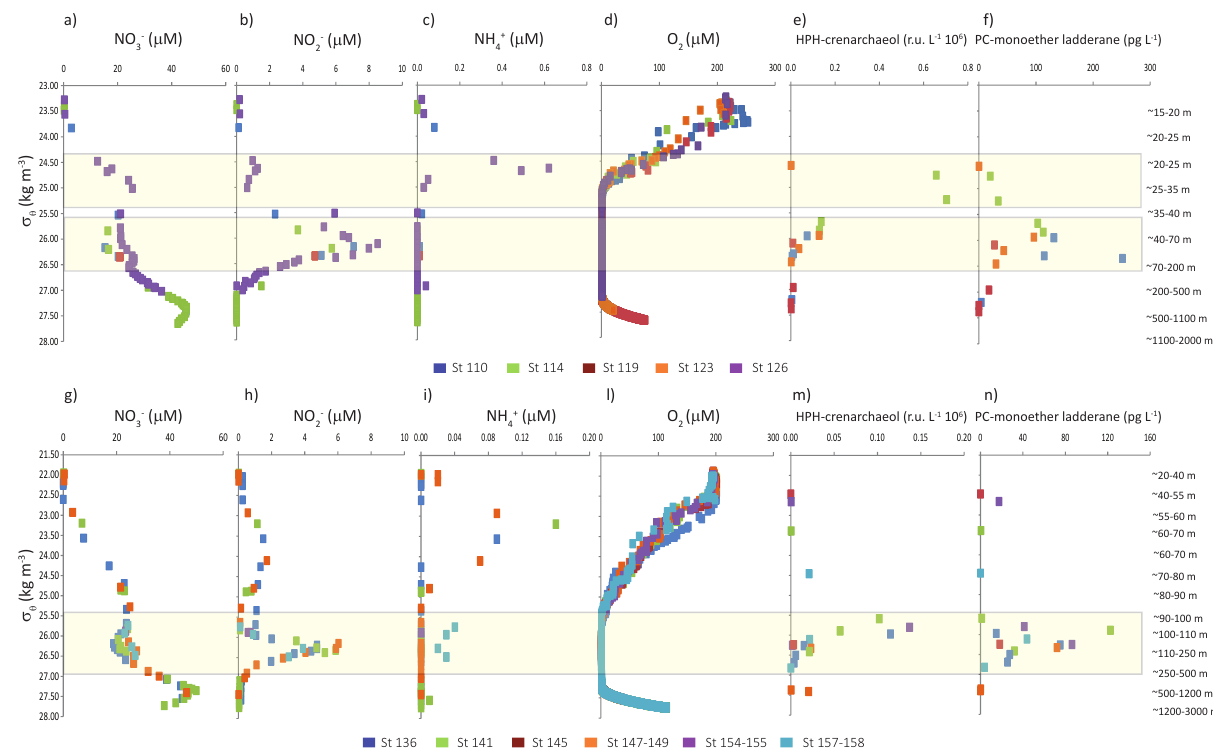
Figure 3. Concentration profiles of ( a , g ) nitrate (NO − ), ( b , h ) nitrite (NO − ), ( c , i ) ammonium (NH + ), ( d , l ) oxygen, ( e , m ) hexose- 3 2 4 phosphohexose (HPH)-crenarchaeol, and ( f , n ) phosphocholine (PC)-monoether ladderane according to the potential density anomalies ( σ θ ) of the water column of the ETNP. The corresponding depths intervals are reported on the right side of the figure as a reference. The upper panels (a–f) provide an overview of the complete water column (2000m) of the coastal sampling site; the lower panels (g–n) show the complete water column (3000m) relative to the open-ocean sampling site. All profiles are obtained by combining the coastal and the open-ocean stations sampled. The yellow bars highlight the main differences observed between the two sampling sites with respect to the distribution of the two microbial species: i.e., on the one hand a clear niche segregation of AOA and anammox bacteria in the coastal waters of the ETNP and on the other hand a partial overlap of the two niches of these microbial species in the open-water setting.